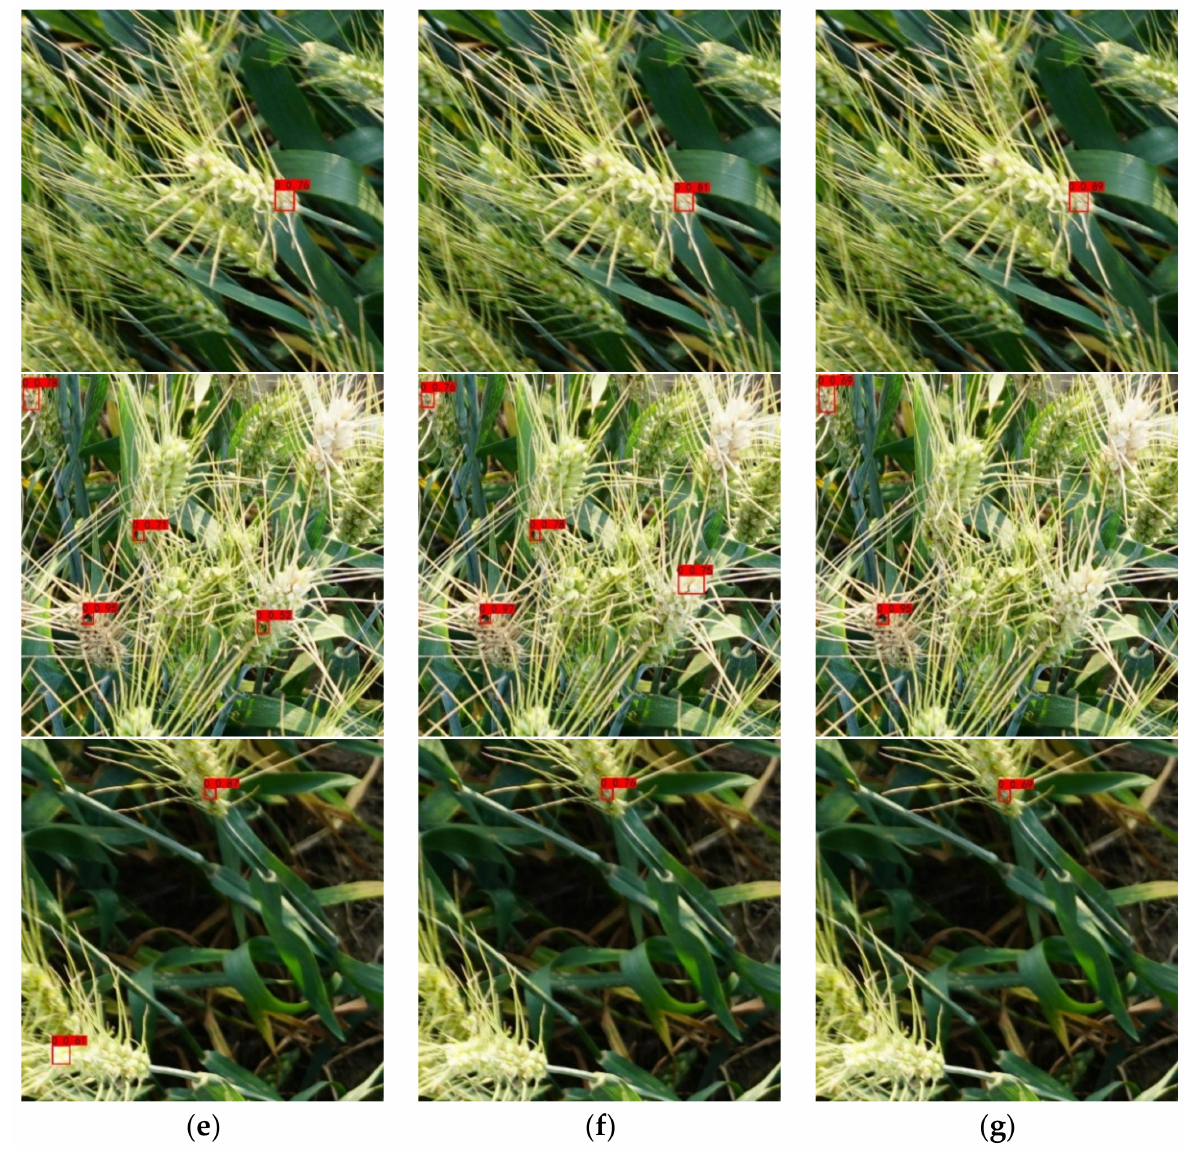
Figure 14. Comparisons of FHB detection with different algorithms. ( a ) The original images. ( b ) YOLOv3. ( c ) YOLOv4. ( d ) YOLOv4-tiny. ( e ) YOLOv4 with ResNet50. ( f ) YOLOv4 with VGG. ( g )